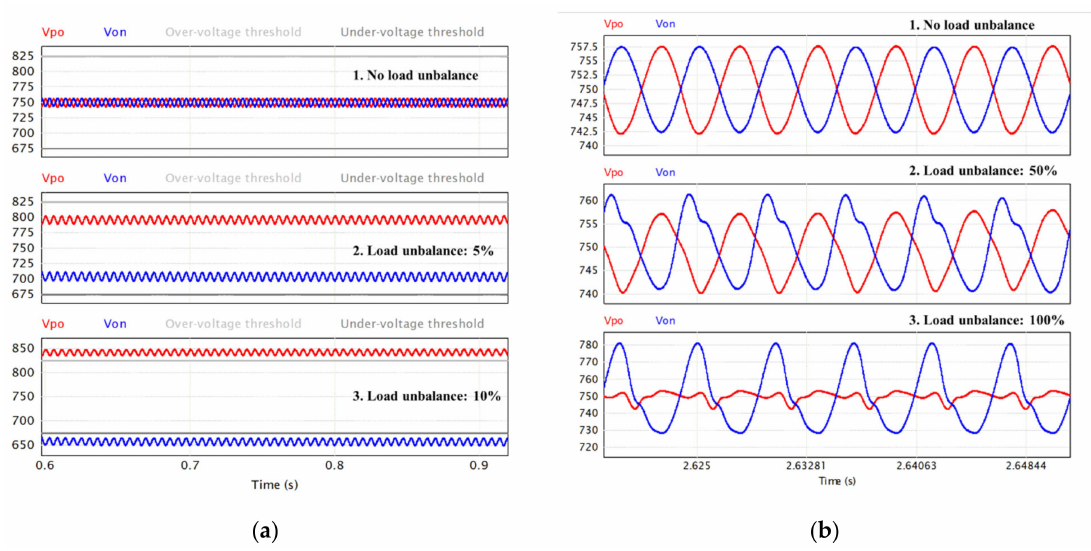
Figure 6. PSIM simulation results of three-level NPC converter with unbalanced load: ( a ) without voltage unbalance compensation algorithm, ( b ) with voltage unbalance compensation